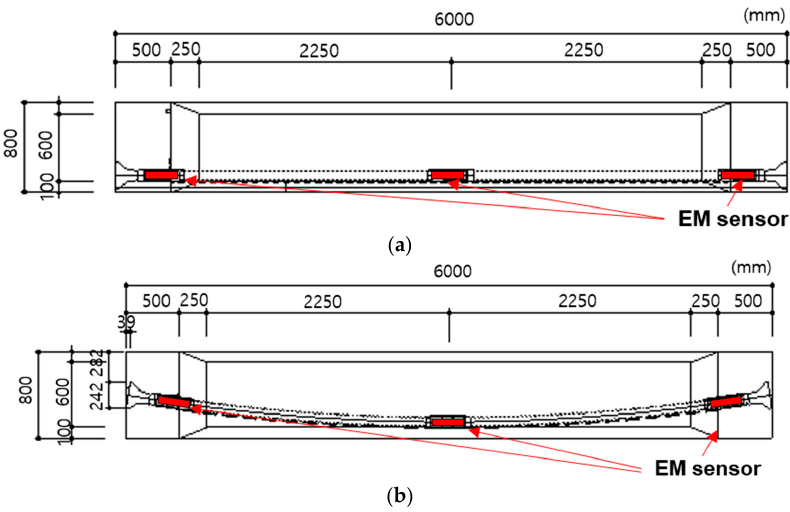
Figure 4. Schematic diagram of the test specimens. ( a ) Specimen 1: Straight sheath; ( b ) Specimen 2: Curved sheath.